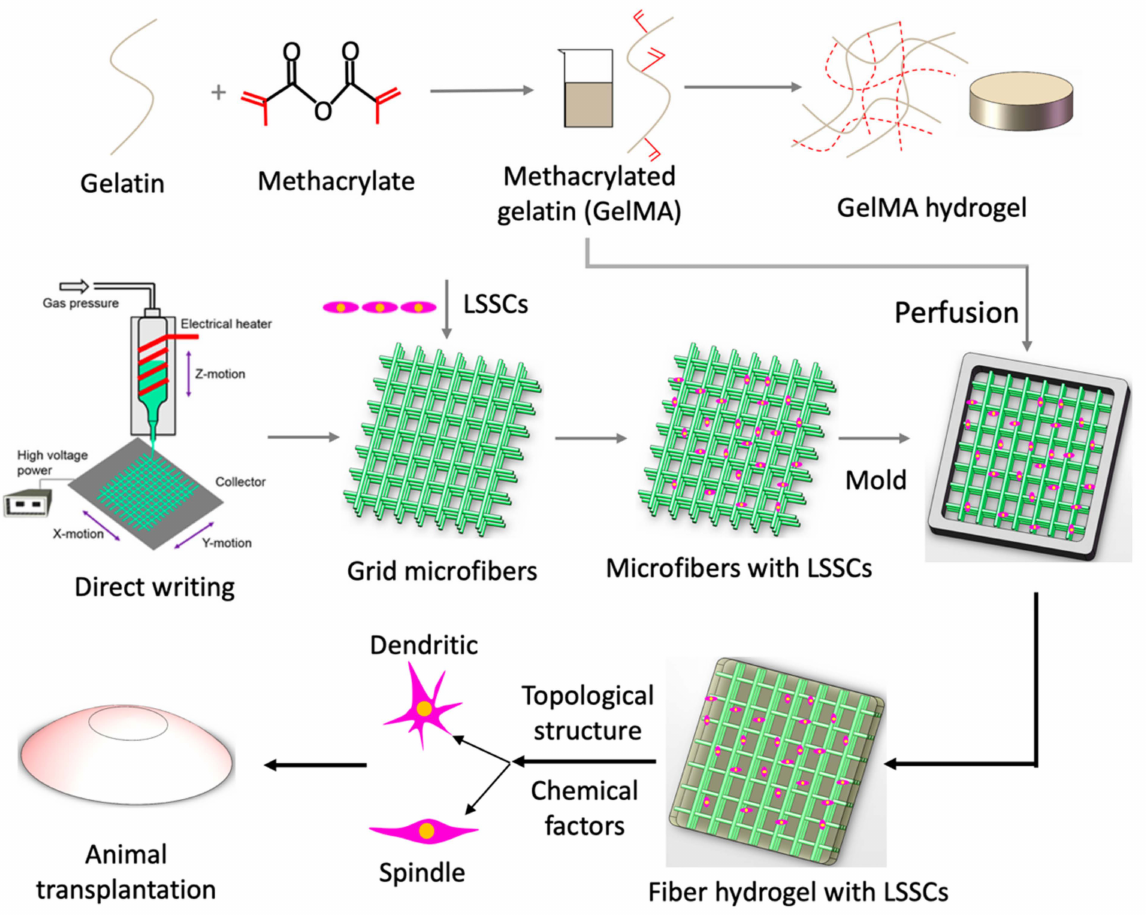
Figure 8. The schematic illustration showing the preparation of fiber reinforced GelMA hydrogel for of the regeneration of the damaged corneal stroma. (Reproduced with permission from [75] under creative commons CC-BY license,